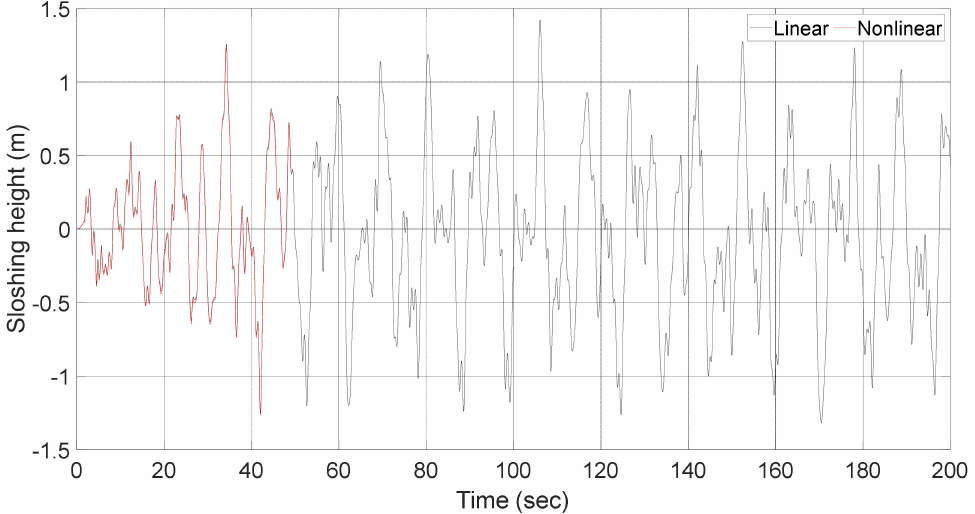
Figure 10. Sloshing heights when the incident angle of the input ground motion is zero.